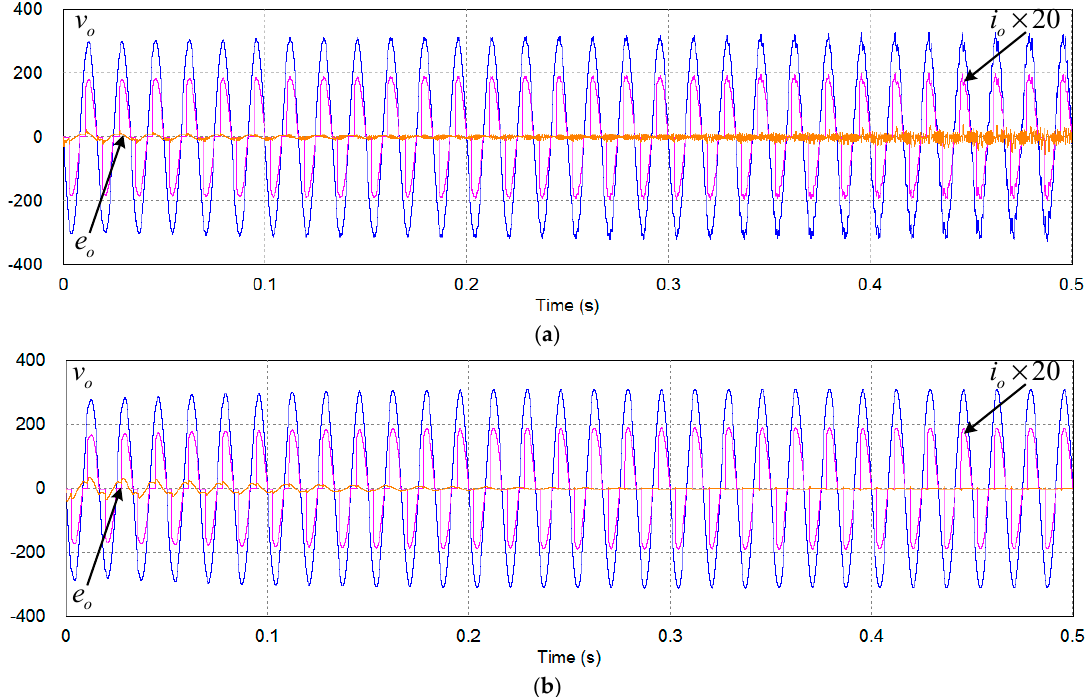
Figure 12. Simulation results using the proposed method with different K d . ( a ) K d = 14; ( b ) K d = 35.